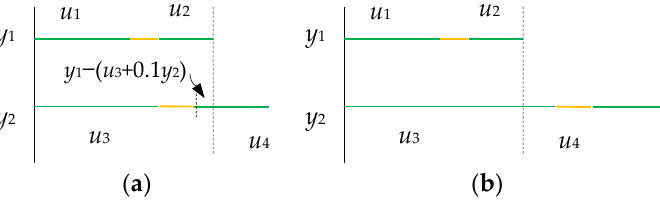
Figure 5. Ratio between cycle and green light durations when y 1 < y 2 , ( a ) u 3 < y 1 , and ( b ) u 3 > y 1 .